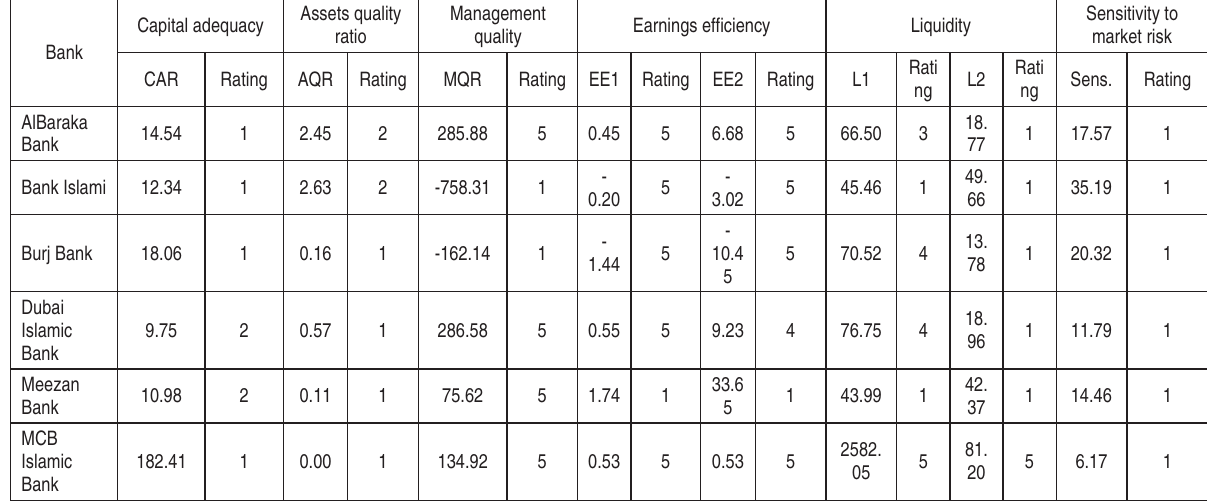
Table 5. CAMELS rating applied to sample banks (financial year ended December